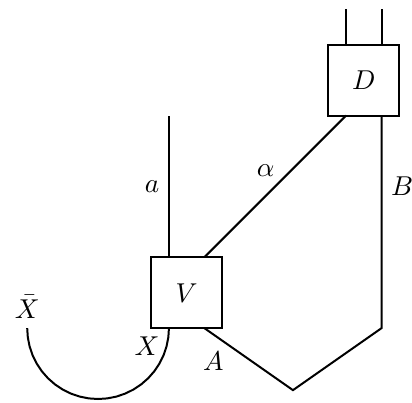
Figure 2. Circuit diagram of a general encoding and decoding procedure for sending secret mes- sages over a public channel. The message X is maximally entangled with a reference system ¯ X . The encoding map V is applied to the message along with part of the resource state A , its XA → aα output is divided into a and α subsystems. a is kept secure. α is sent over the public channel. The decoding procedure attempts to recover the X system from αB . System α should reveal nothing about X